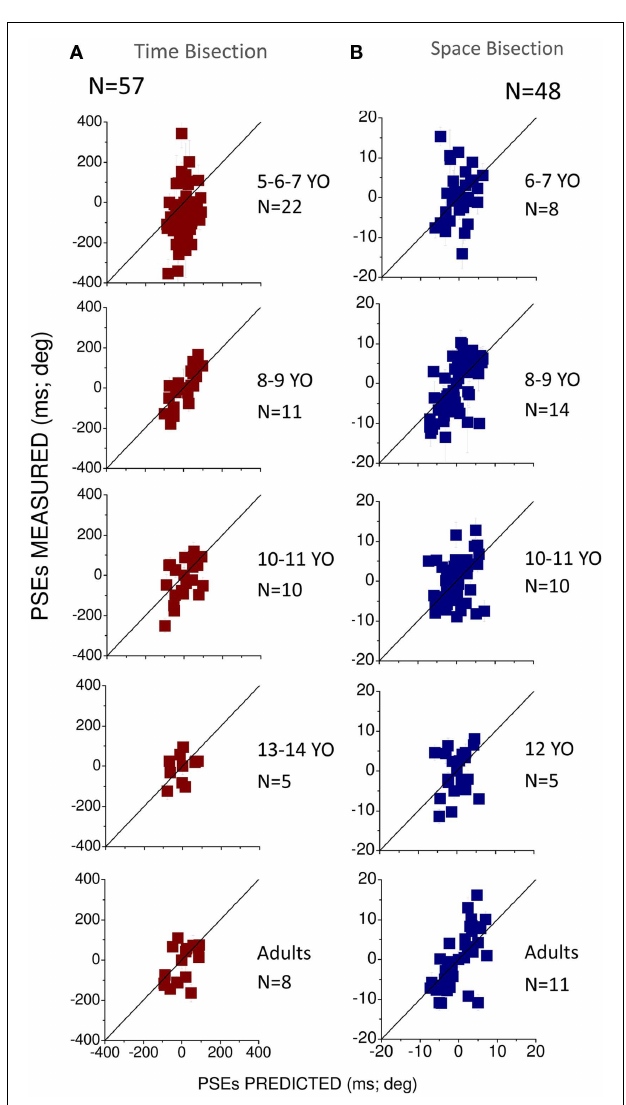
FIGURE 3 | (A) PSEs measured for the different conflictual condition in the temporal bisection task. (B) PSEs measured for the different conflictual condition in the spatial bisection task. In both panels the green line represents total auditory dominance and the red line total visual dominance. Different ages are reported in different panels.The number of subjects who participated is indicated in each panel for each age and condition. ( Figure 6B ),the PSE has less auditory weight (more visual weight)